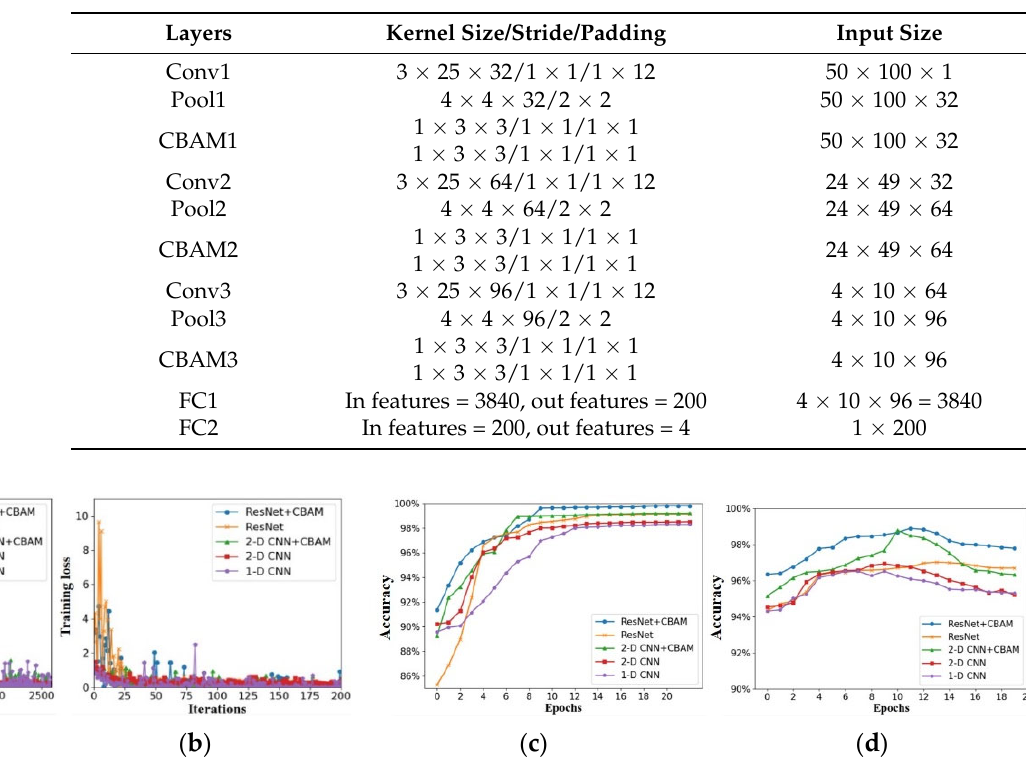
Table 4. Structural parameters of the 2-D CNN+CBAM network.